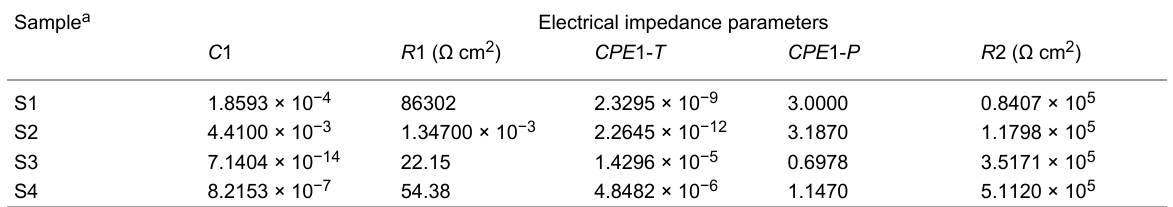
Table 5: Parameters obtained for each artificial circuit. Sample